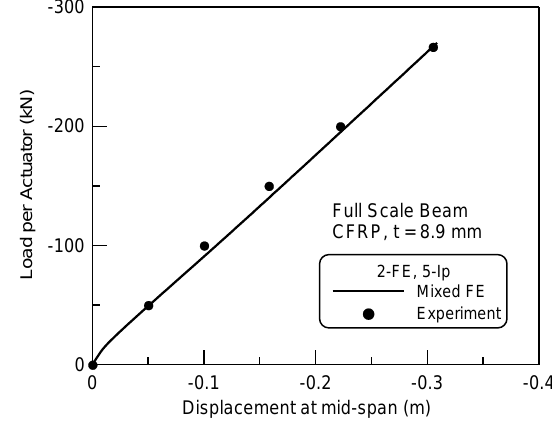
Figure 7. Transverse load and displacement responses of the